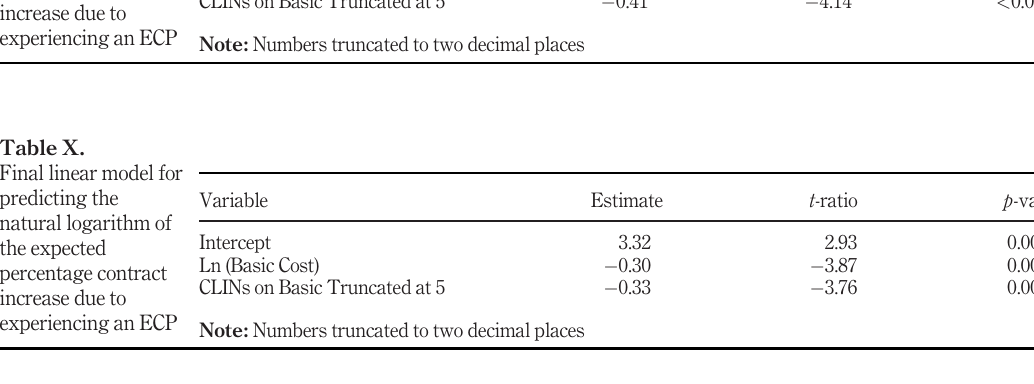
Table XI compares using equation (1) to three other ECP withhold methods. For all methods, we use the entire sample database of 533 contracts for the comparisons. The fi rst method assumes no ECP withhold, essentially assuming the contract never Table IX. Candidate linear model for predicting the natural logarithm of the expected percentage contract increase due